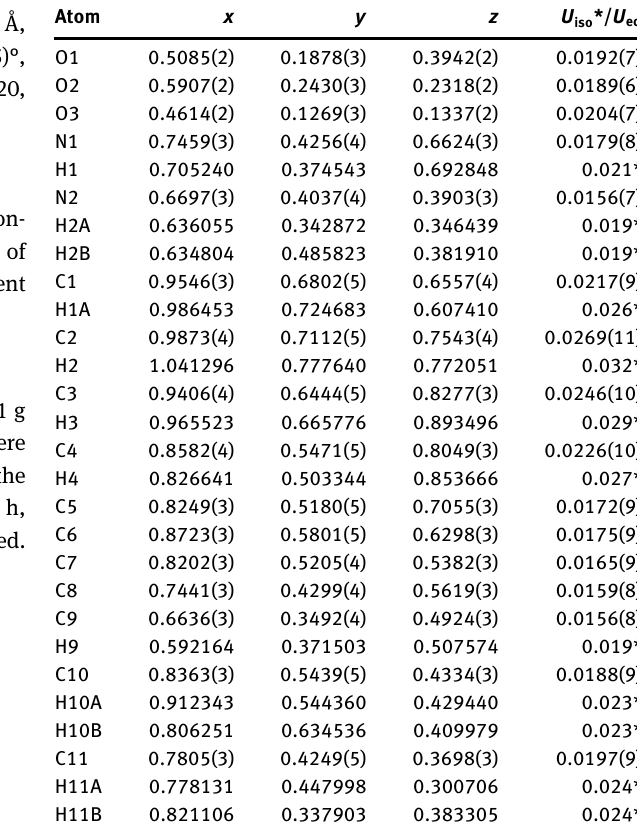
Table 2: Fractional atomic coordinates and isotropic or equivalent isotropic displacement parameters (Å 2